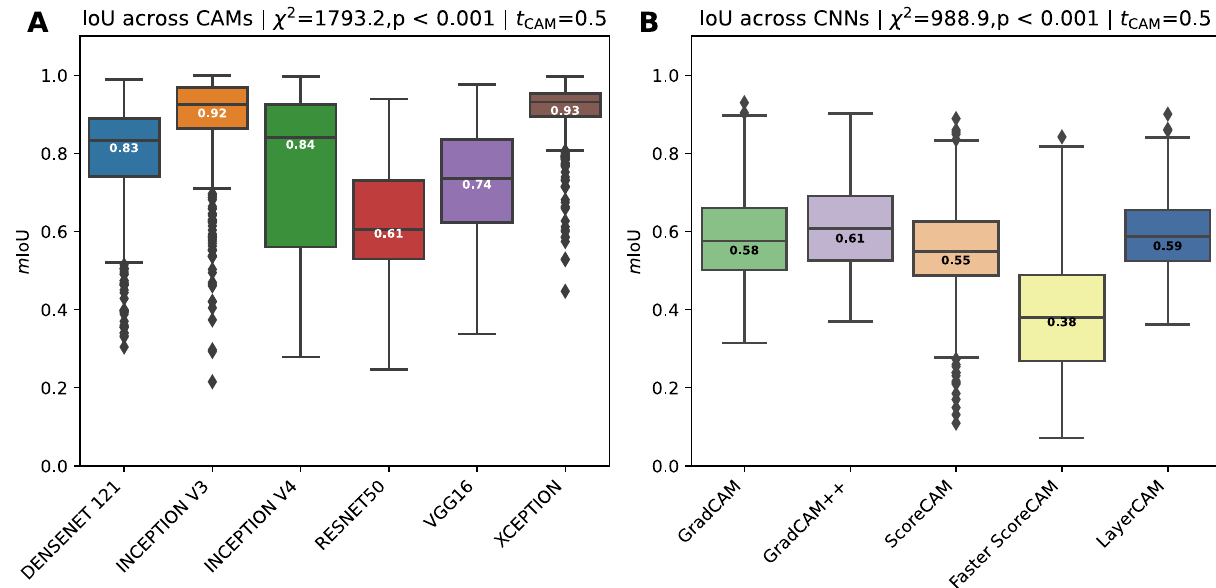
Figure 5. ( A ) The IoU agreement across CAM methods. It reflects the degree to which CAM activations obtained from different CAM methods have a high IoU with each other while fixing the CNN model. ( B ) The IoU agreement across different CNN models while fixing the CAM method. This agreement is measured by calculating the average intersection over union between unique combinations of CNN models. Median values are shown in the